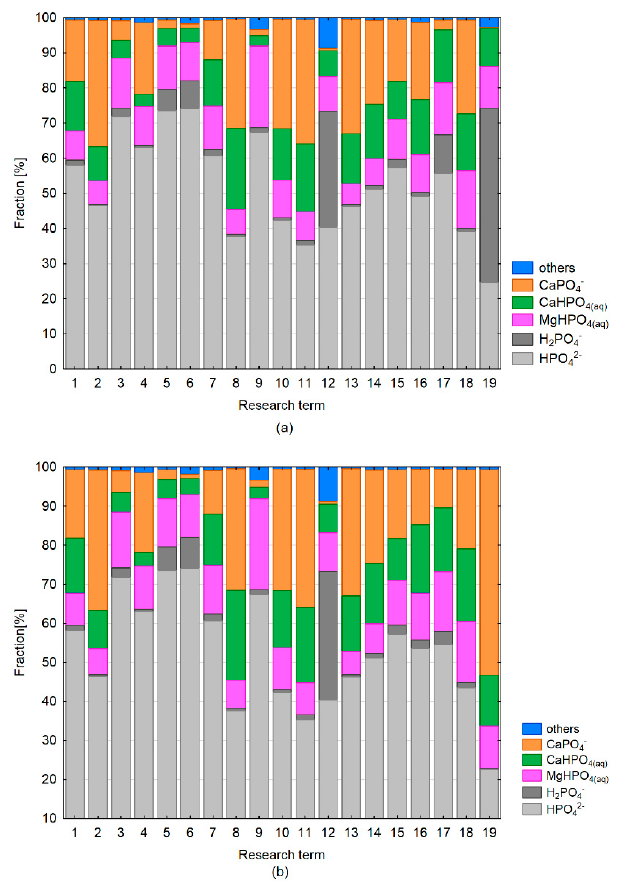
Figure 6. Speciation forms of orthophosphates (V) in the waters of Lake Kórnickie at SPs JK1 ( a ) and JK2 ( b ).